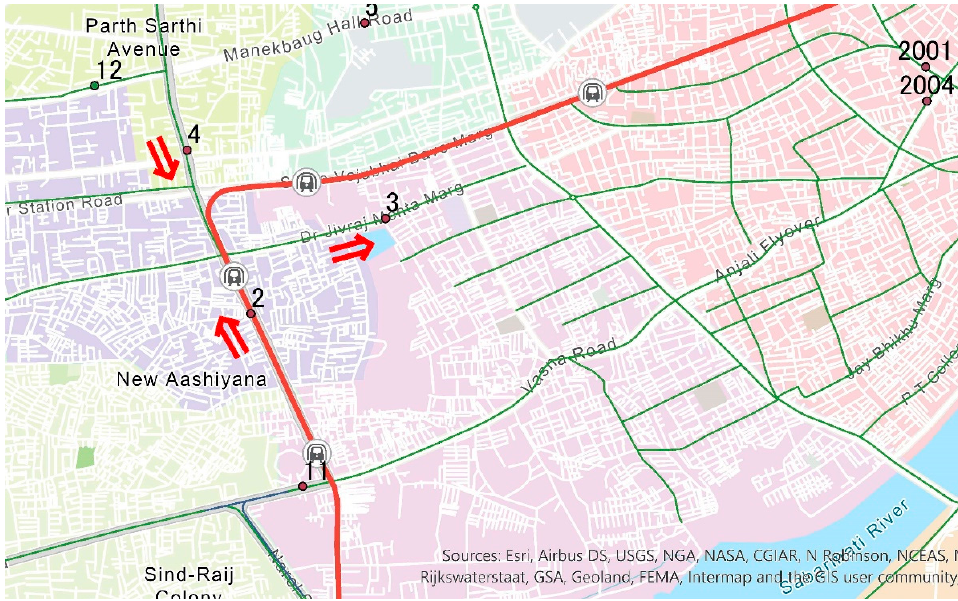
Figure 11. Relationship between traffic volume and occupancy in Ahmedabad (red line is under development for the first Metro in Ahmedabad and the train mark is the Metro station).